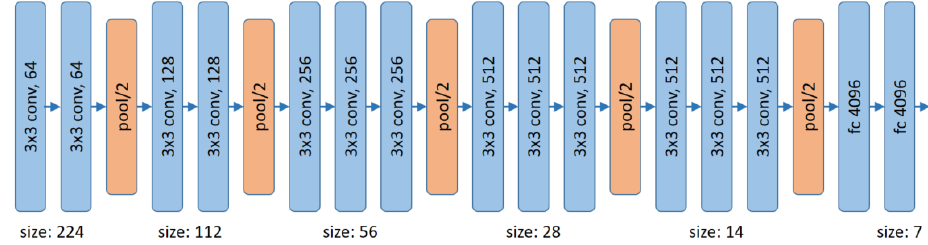
Figure 5. Architecture of VGG-16 [34].